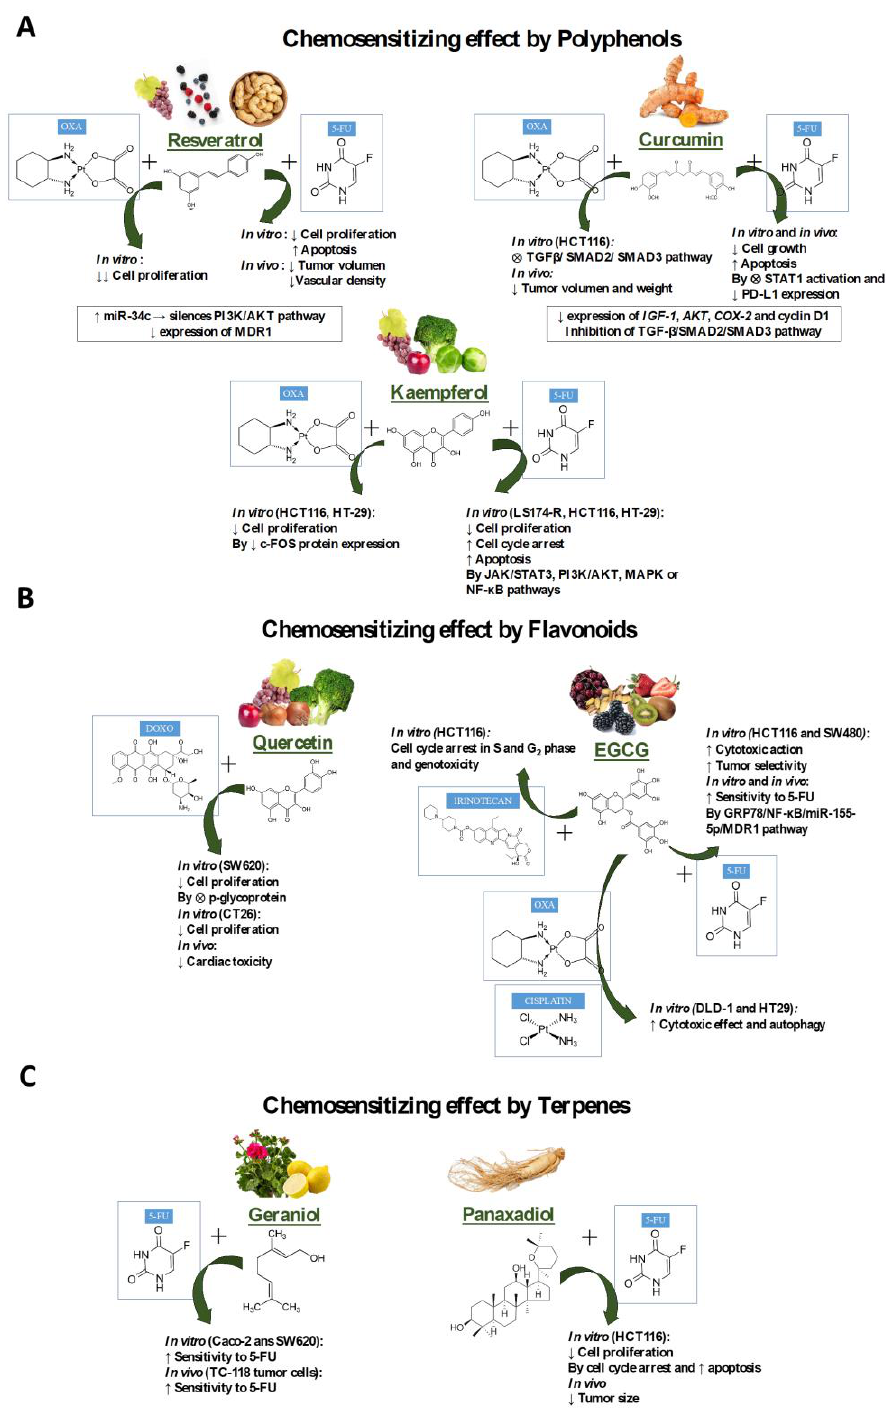
Figure 2. Sensitizing effect on chemotherapeutic drugs that are frequently used in CRC exerted by natural compounds of the following families ( A ) polyphenols, ( B ) flavonoids, and ( C ) terpenes, an- alyzed in this review. DOXO (doxorubicin); 5-FU (5-fluorouracil); OXA